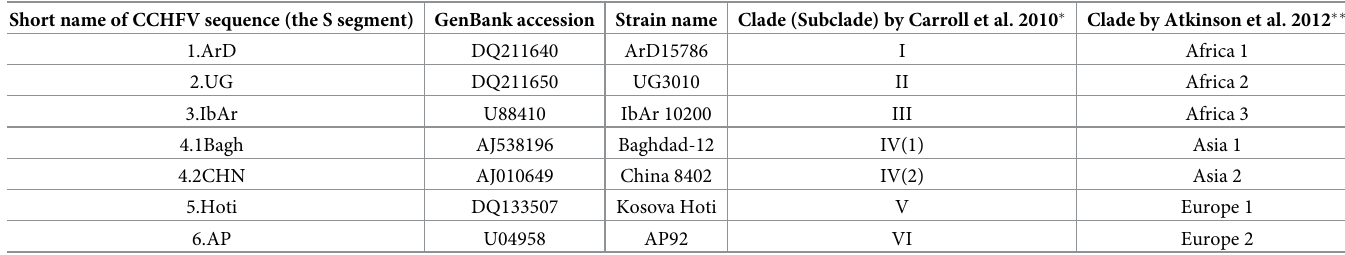
Table 1. Clade-representing CCHFV